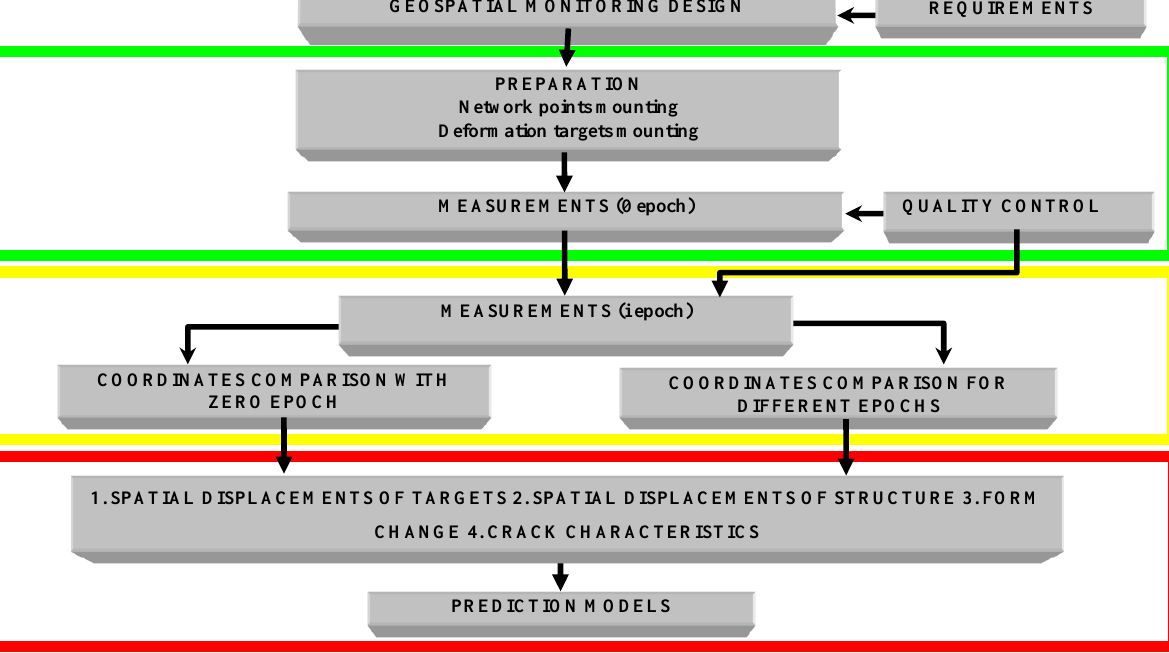
Figure 1 . Workflow scheme of geospatial monitoring.